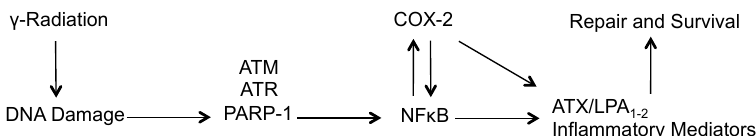
Figure 3. Overview of γ -radiation-induced inflammation in adipose tissue. γ -radiation, upon inducing double strand DNA breaks, activates the proteins ATM, ATR, and PARP-1. These in turn activate NF κ B, facilitating the expression of COX-2, ATX, LPA 1–2 and numerous inflammatory mediators, which in concert lead to repair and survival of tissues.